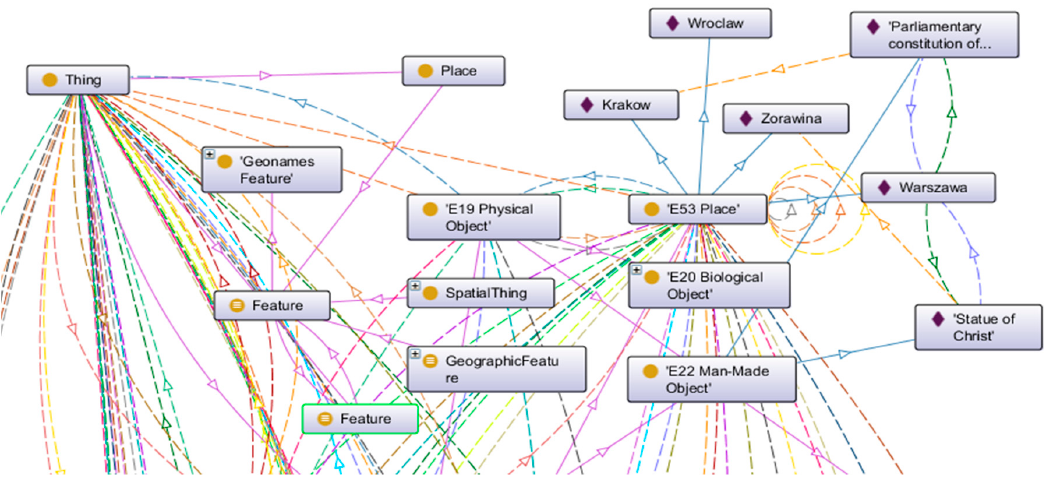
Figure 12. A sample of the ontology’s graph representation of the example datasets (source: own work).